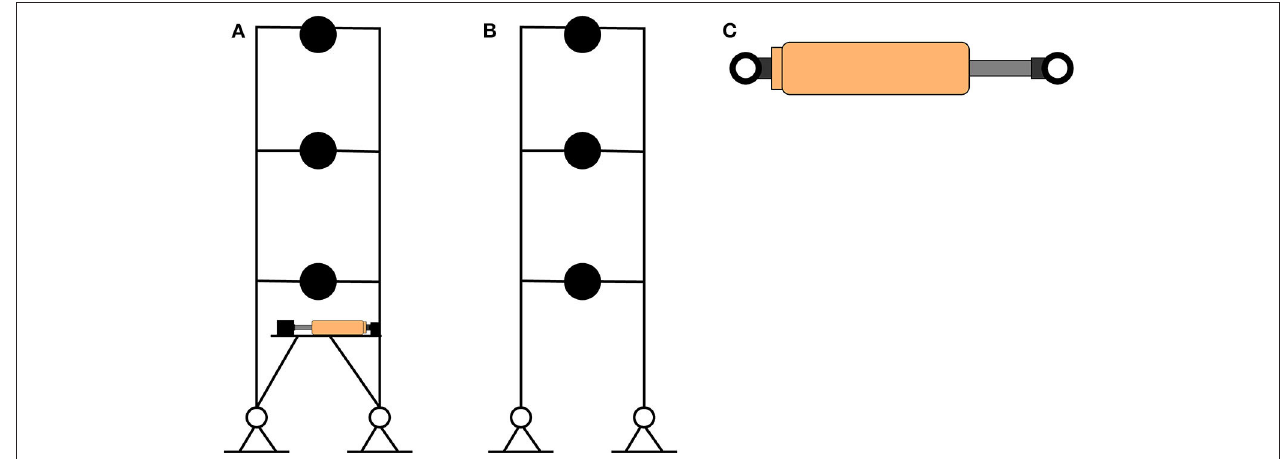
FIGURE 10 | Hybrid model of CS2: (A) Reference structure, (B) Numerical substructure, (C) Virtual physical substructure.